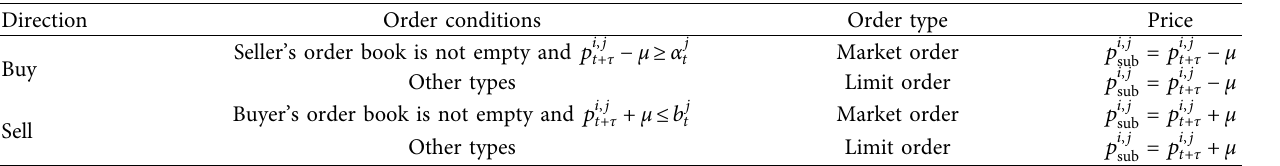
Table 3: Investors’ order.